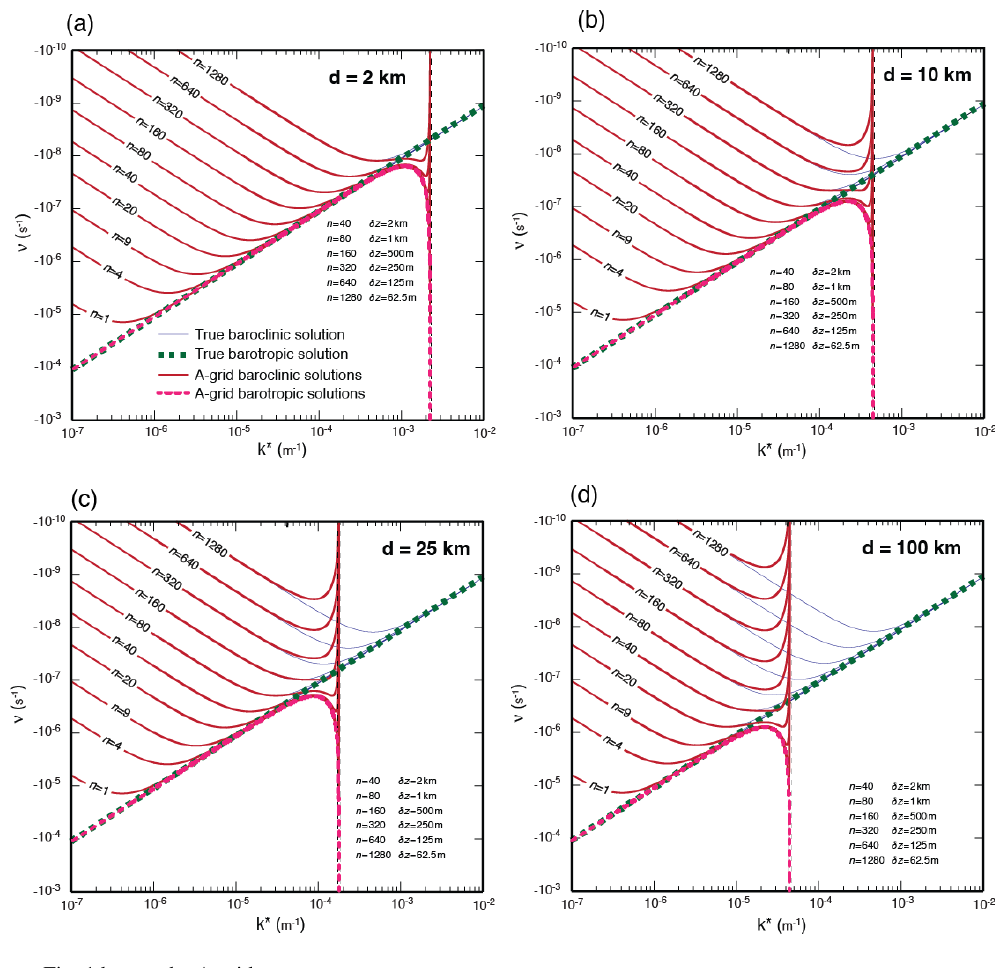
Figure 4. Same as Fig. 1 but on the A